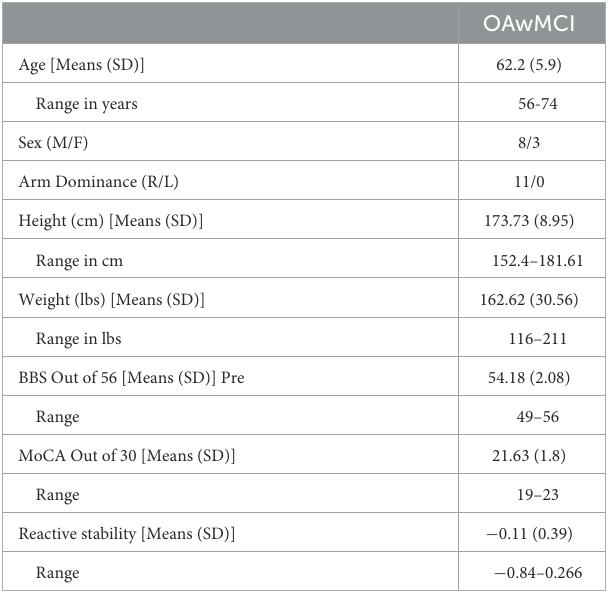
TABLE 1 Demographics and clinical characteristics of older adults with mild cognitive impairment